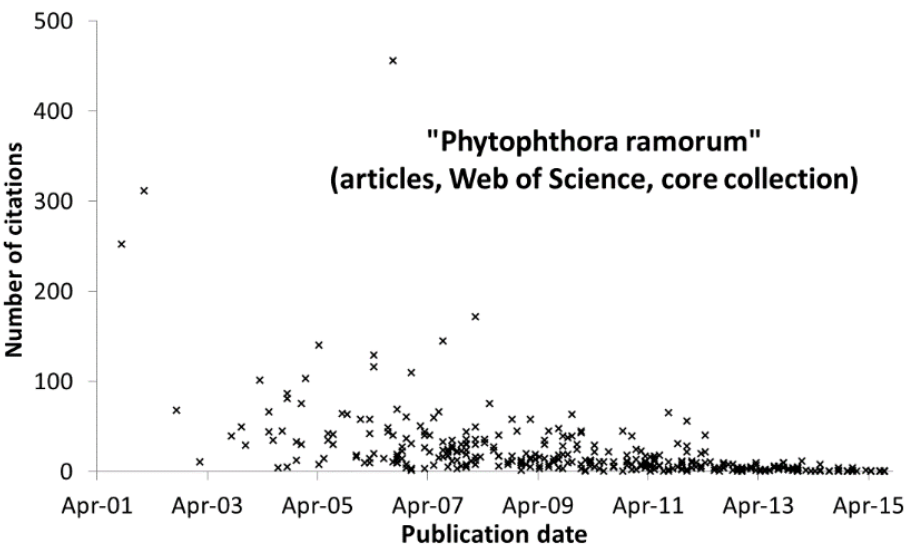
Figure 5. Number of citations received by the 353 articles (April 2001–September 2015) retrieved with the keyword “ Phytophthora ramorum ” in Web of Science (core collection, as of September 2015, excluding reviews, book reviews, meeting abstracts, editorials and news items). Note that the Web of Science database also lists some review papers as articles (but the pattern shown is essentially the same even if further refining the list of articles considered).